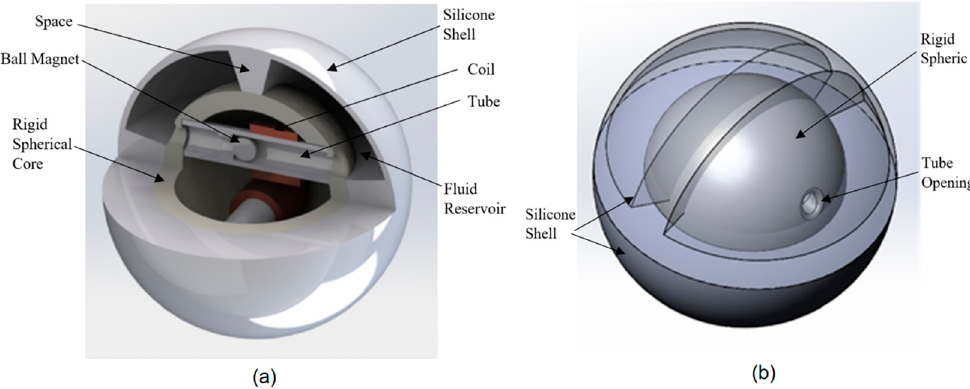
Figure 1. SolidWorks model of the energy harvester showing internal features ( a ) and the rigid spherical core and the silicone shell ( b ).